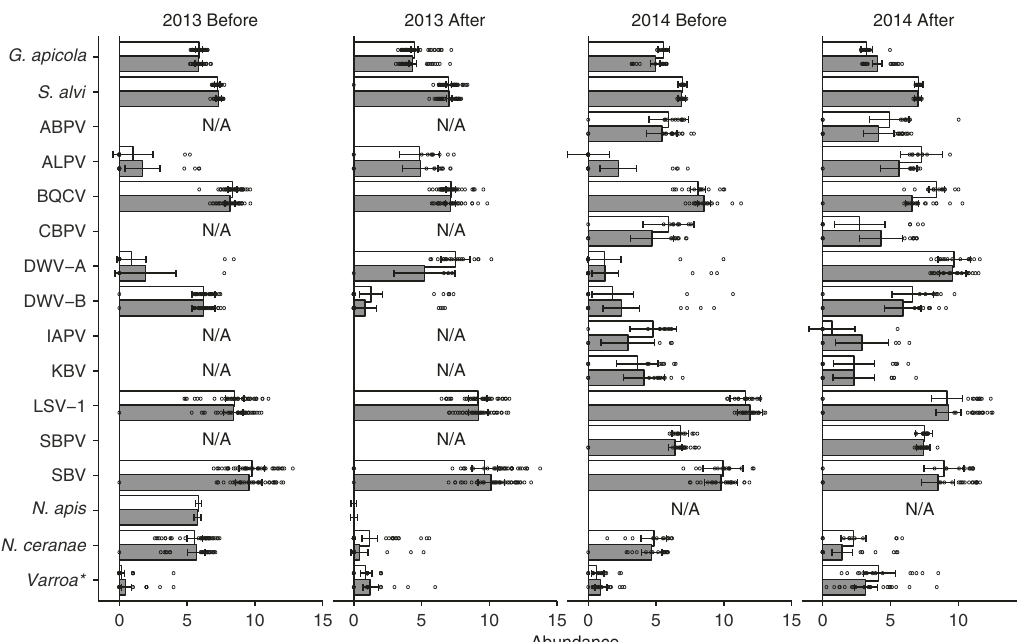
Fig. 5 Microorganism/parasite abundance. The abundance (±95% con fi dence intervals) of frequently detected target organisms ( Gilliamella apicola , Snodgrassella alvi , acute bee paralysis virus (ABPV), black queen cell virus (BQCV), deformed wing virus type-A (DWV-A), deformed wing virus type-B (DWV-B), Israeli acute paralysis virus (IAPV), Kashmir bee virus (KBV), Lake Sinai virus 1 (LSV-1), slow bee paralysis virus (SBPV), Sacbrood virus (SBV), Nosema ceranae and Varroa destructor ) in honeybee colonies in relation to the treatment (control = white bars; clothianidin-treated = grey bars) in oilseed rape fi elds ( n = 8 fi elds per treatment in 2013; n = 4 control and n = 6 treated fi elds in 2014) before and after the oilseed rape bloom in two years (2013 and 2014). *The abundance of V. destructor was represented by the number of mites per 100 bees, while the microorganisms were expressed as log 10 [units] per bee 70 . Microorganism abundance was not analysed (N/A) if it was detected in less than 11 samples per year. Circles indicate measured